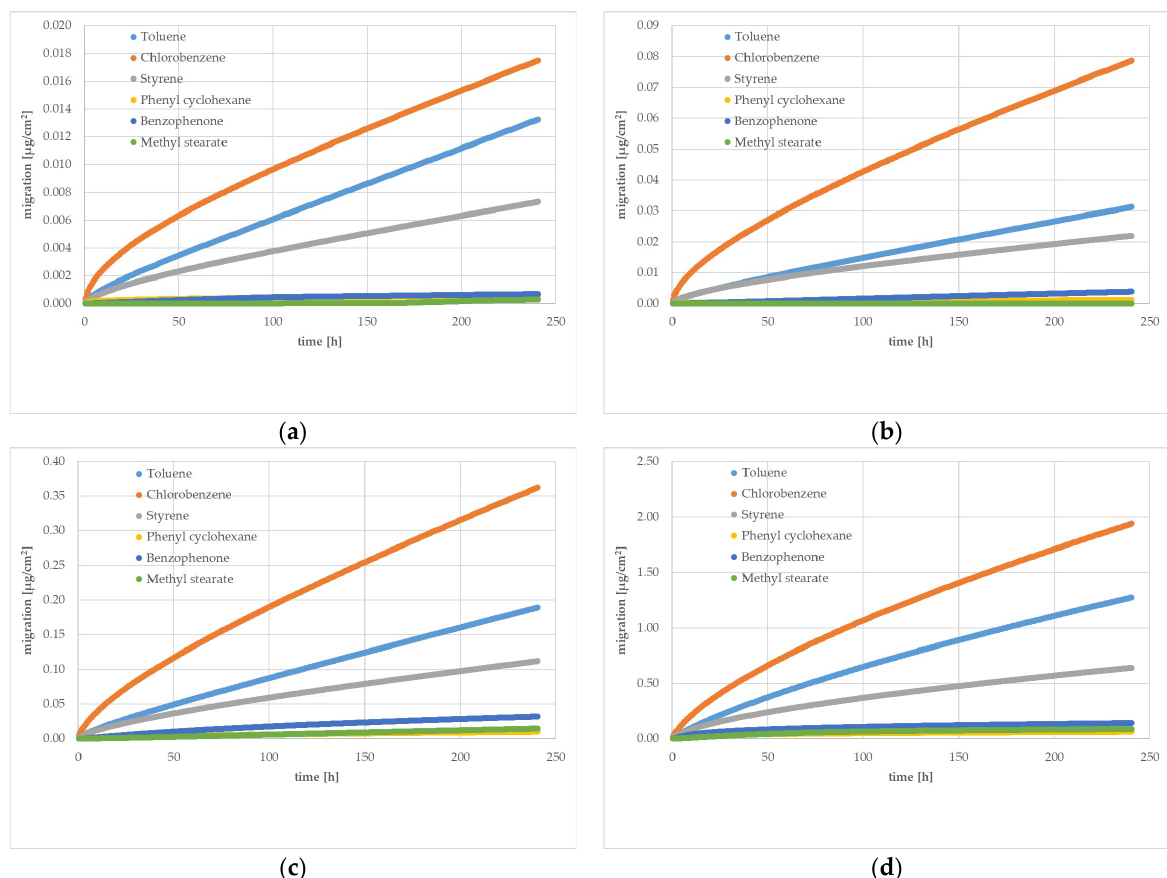
Figure 1. Experimentally determined gas phase migration kinetics of from HIPS at 5 °C ( a ), 20 °C ( b ), 40 °C ( c ) and 60 °C ( d ). Spiking levels for the different substances are indicated in Section